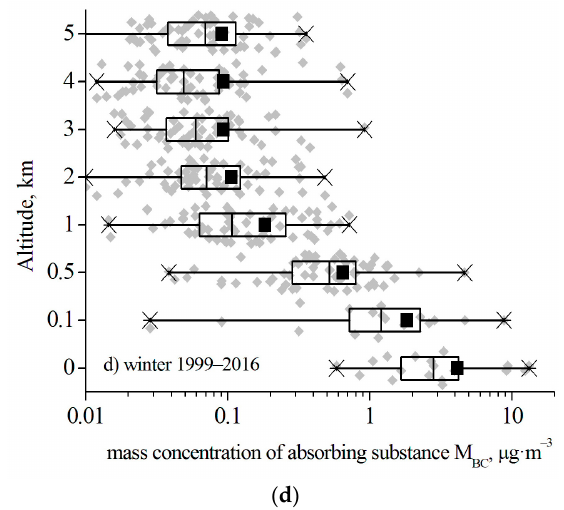
Figure 1. Distributions of the angular scattering coefficient ( a , b ) and mass concentration of absorbing substance (black carbon) ( c , d ) at different altitudes in summer ( a , c ) and winter ( b , d ).